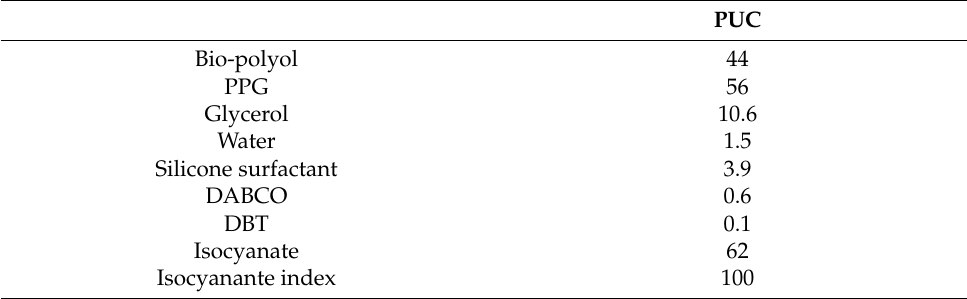
Table 3. Staring formulation of the foam used in this study